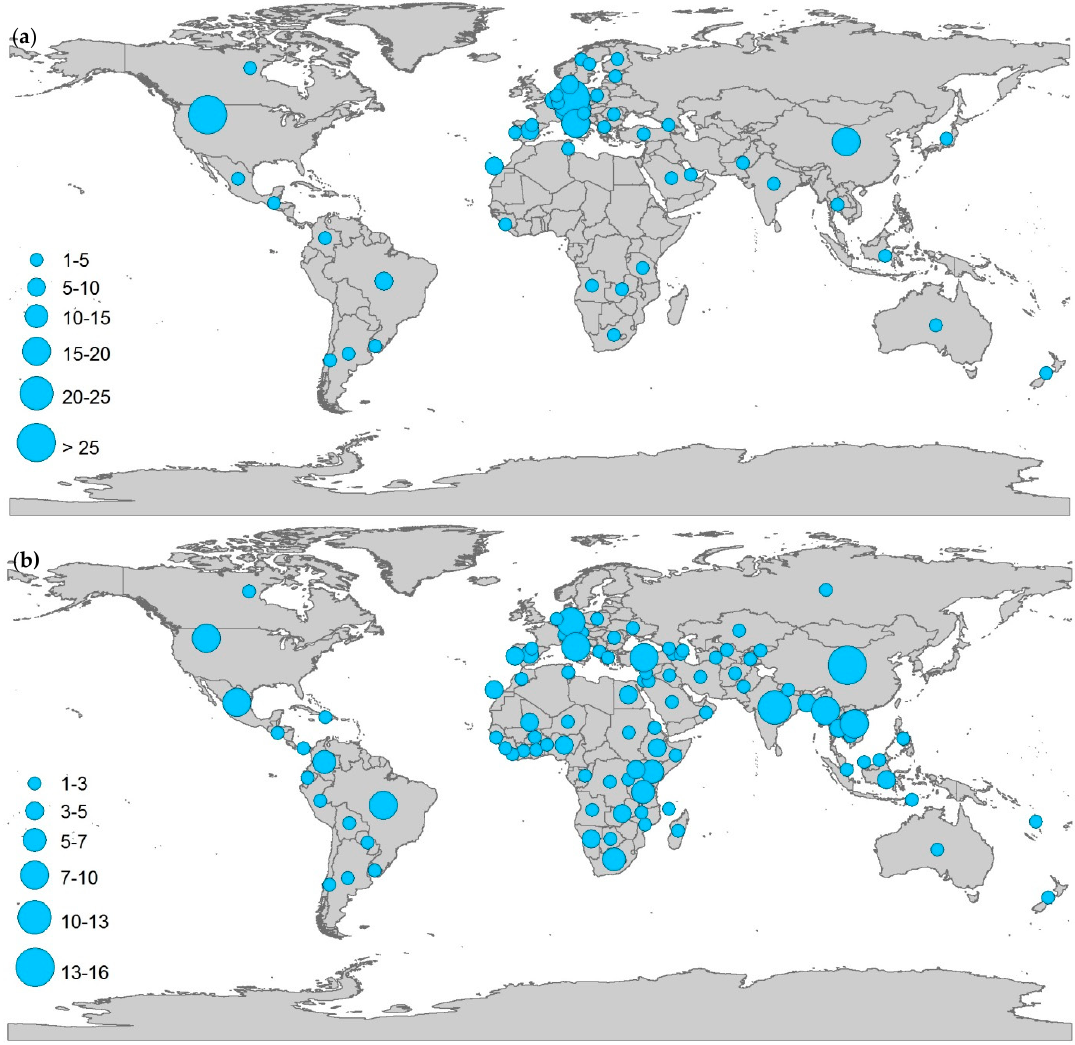
Figure 4. Visualization of the amount and origin of GUF users ( a ) per country and the distribution of the related areas of interest ( b ).